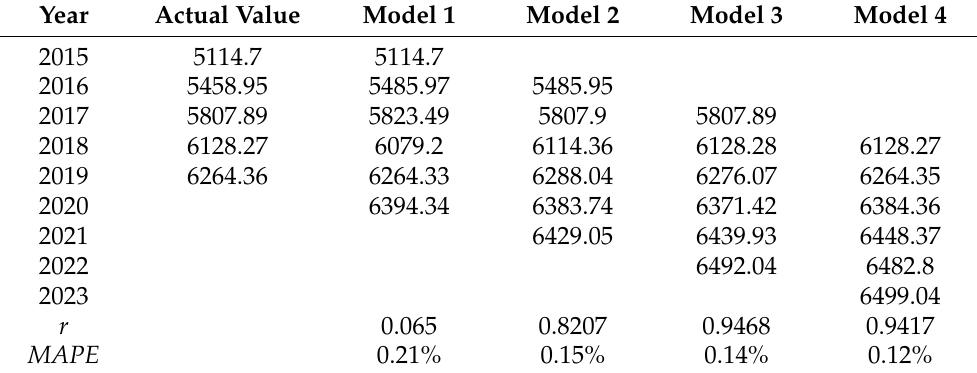
Table 3. Results of metabolic FGM (1, 1) model (100 million kW ·